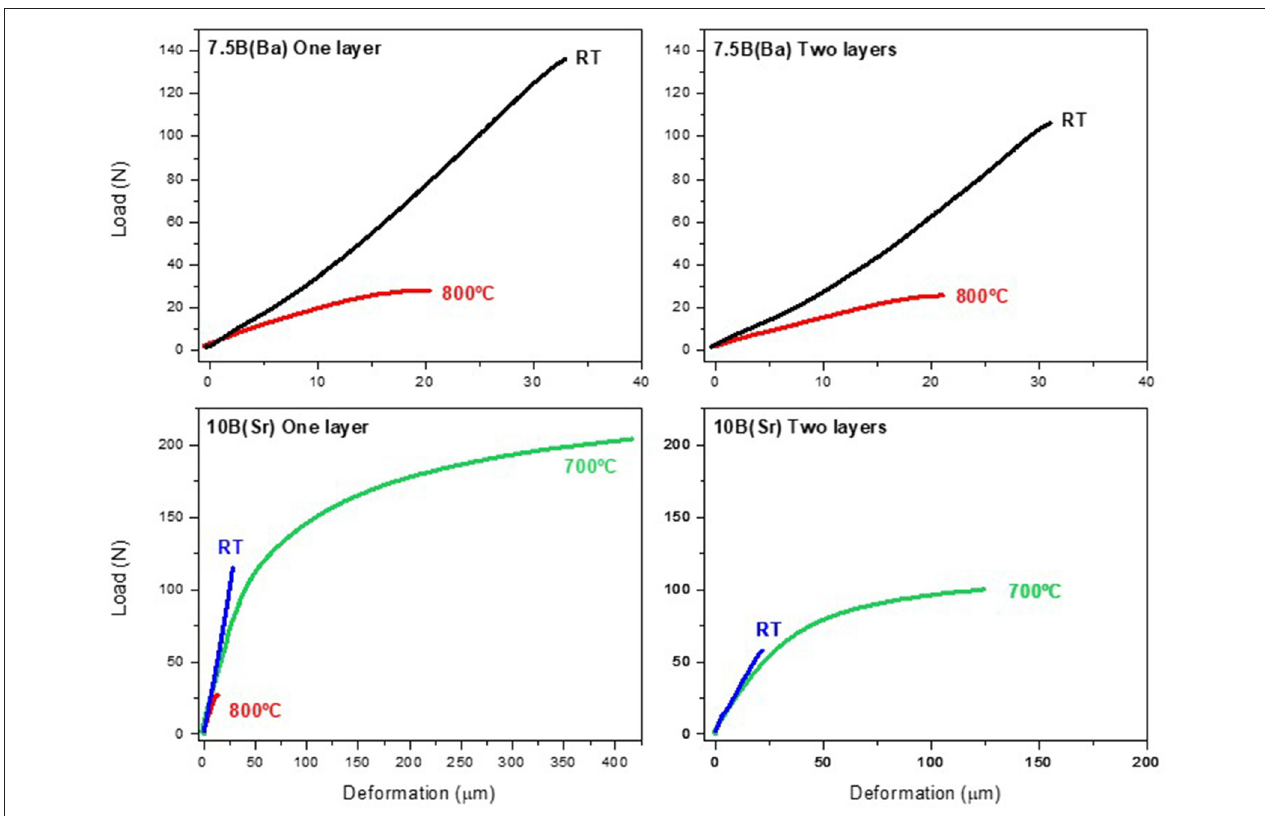
FIGURE 8 | Load-deformation curves for the bars sealing with one or two layers applied by screen printing as a function of testing temperature for compositions 7.5B(Ba) and 10B(Sr).